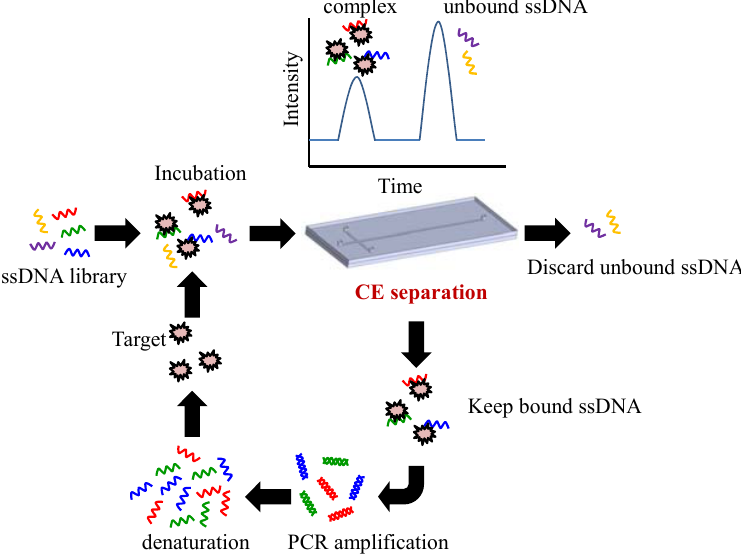
Figure 1. Schematic illustration of the SELEX processes in CE-microfluidic chips. A library of ssDNA is incubated with the target molecules. Capillary electrophoresis is used to separate bound sequences. Binding nuclear acids are amplified by PCR and purified giving an enriched ssDNA pool which suitable for further rounds of selection. High-affinity aptamers are typically obtained after two to four rounds of